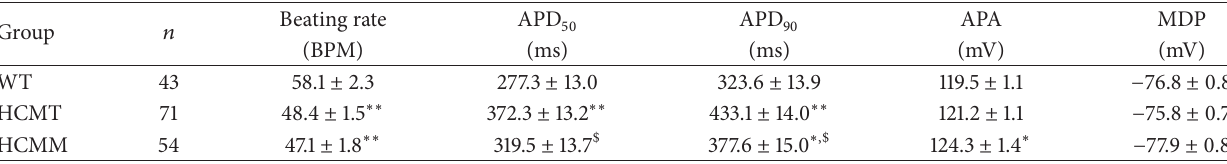
Table 3: AP properties of ventricular-like CMs derived from control hiPSC lines (WT) and from hiPSC lines carrying